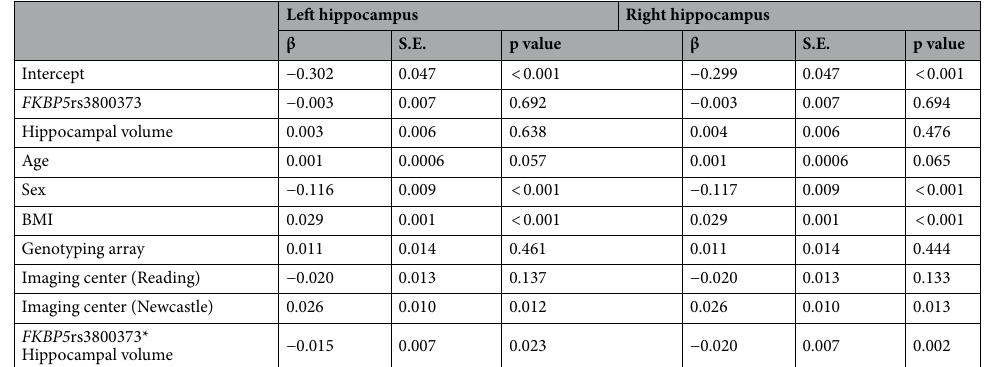
Table 2. Linear regression analyses assessing the interaction between FKBP5 genetic risk, using the tagging allele rs3800373, and left and right hippocampal volumes on chronic multisite musculoskeletal pain in the UK Biobank (n = 36,822). Chronic multisite musculoskeletal pain was defined as the number of musculoskeletal sites with pain that persisted for more than 3 months, ranging from 0 to 4. An additive genetic model was used to assess the effect of rs3800373. Genetic principal components 1–10 and ethnic background were included as covariates but omitted from the table for